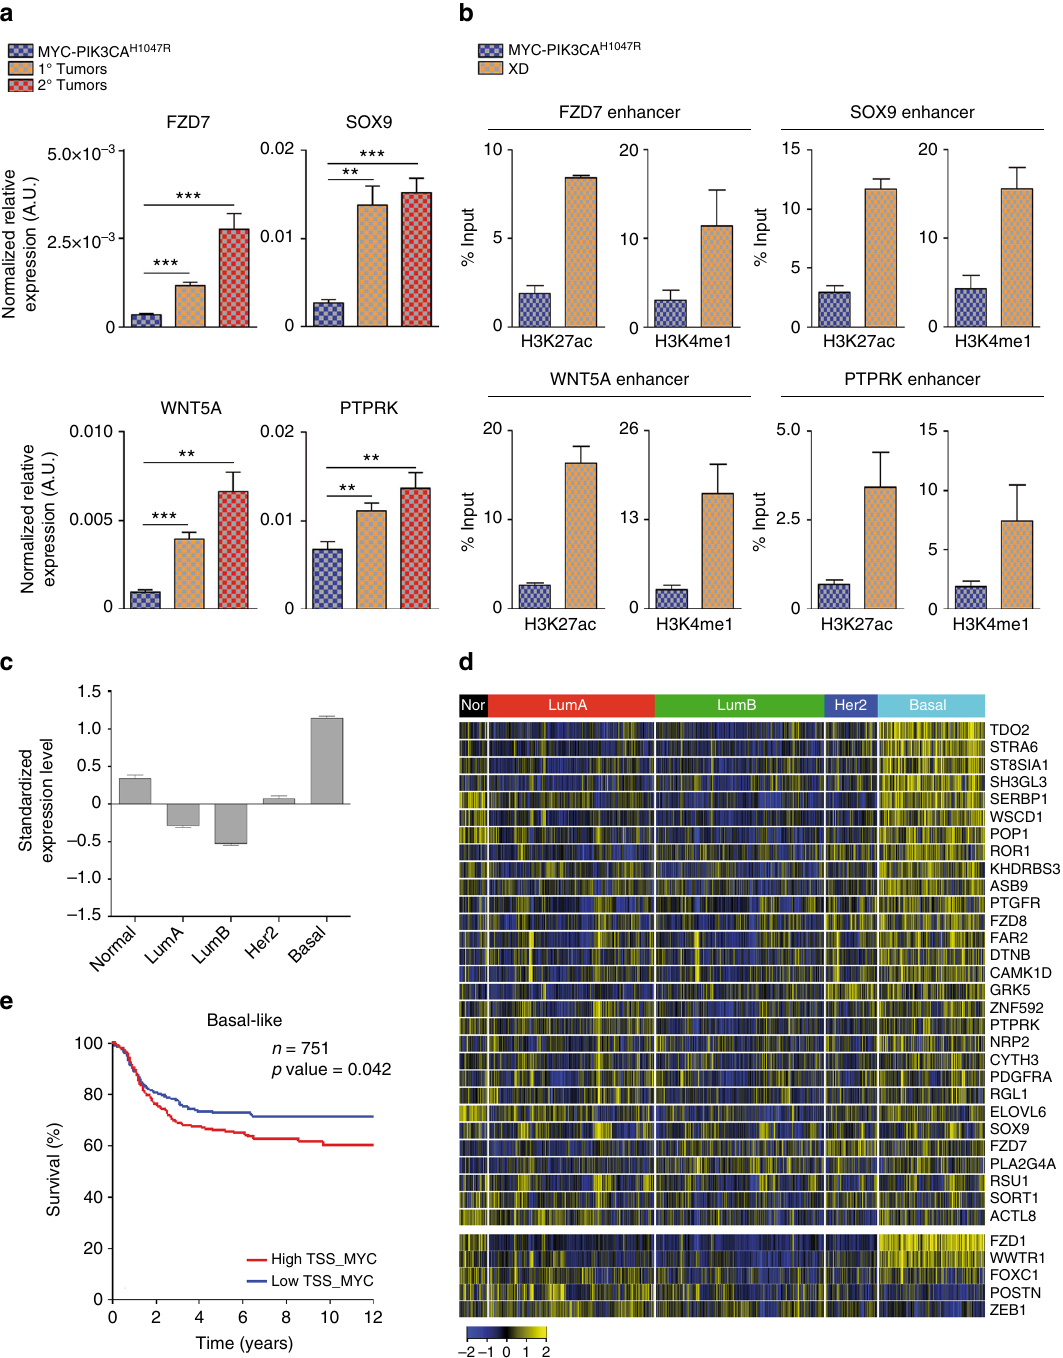
Fig. 7 MYC-induced activation of oncogenic pathways in TICs. a qRT-PCR of genes associated to MYC-bound M2 de novo enhancers in IMEC-MYC- PIK3CA H1047R and 1° and 2° xenograft tumors cells, normalized on GAPDH. Data are means ± SEM ( n = 3) (** P < 0.01, *** P < 0.001; Student ’ s t- test). b ChIP-qPCR assessing H3K27ac and H3K4me1 deposition at the MYC-bound M2 de novo enhancer regions in IMEC-MYC-PIK3CA H1047R and XD cells. Data are means ± SEM ( n = 3). c Average gene expression values of MYC direct target signature in breast cancer samples of the meta-data set strati fi ed according to molecular subtype. Data are shown as mean ± standard error of the mean (SEM) ( P < 0.0001; unpaired t test). d Gene expression levels of MYC direct target genes (upper heatmap) and of basal-speci fi c enhancer associated genes (MYC un-bound; lower heatmap) in breast cancer samples of the meta-data set strati fi ed according to molecular subtype. e Kaplan − Meier analysis representing the probability of metastasis-free survival in 751 basal- like breast cancer patients from the meta-data set strati fi ed according to high or low MYC direct target signature